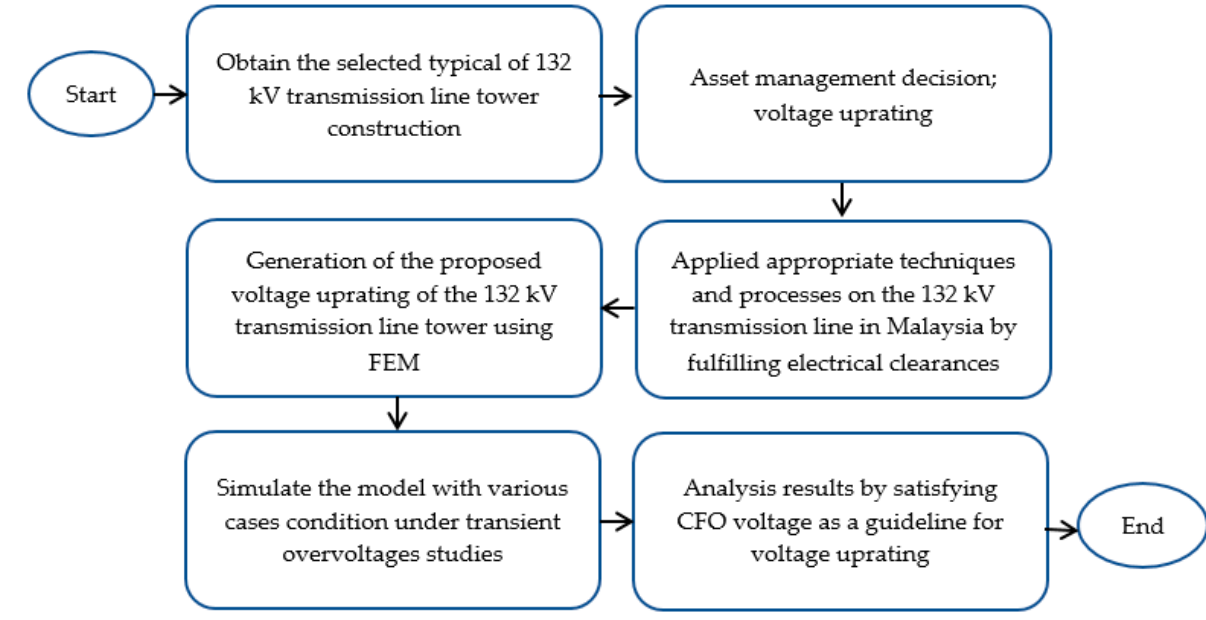
Figure 1. The model proposal framework simulates and analyses the voltage uprating of 132 kV transmission lines in Malaysia.